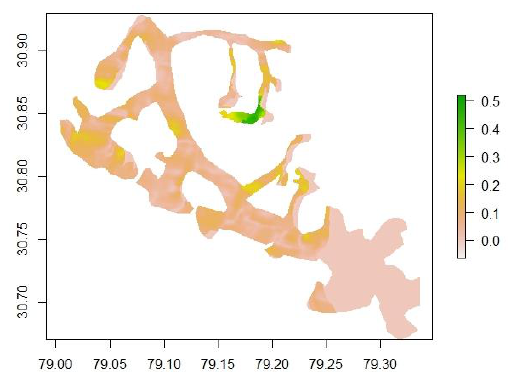
Figure 9: Gangotri glacier velocity map obtained descending pass Sentinel-1A images (10 May 2018 and 22 May 2018) (Figure scale in m day -1